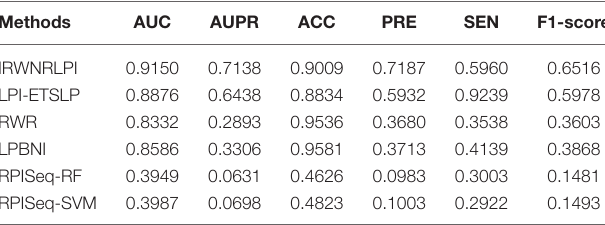
TABLE 1 | Comparison of IRWNRLPI with LPI-ETSLP, RWR, LPBNI, and RPISeq